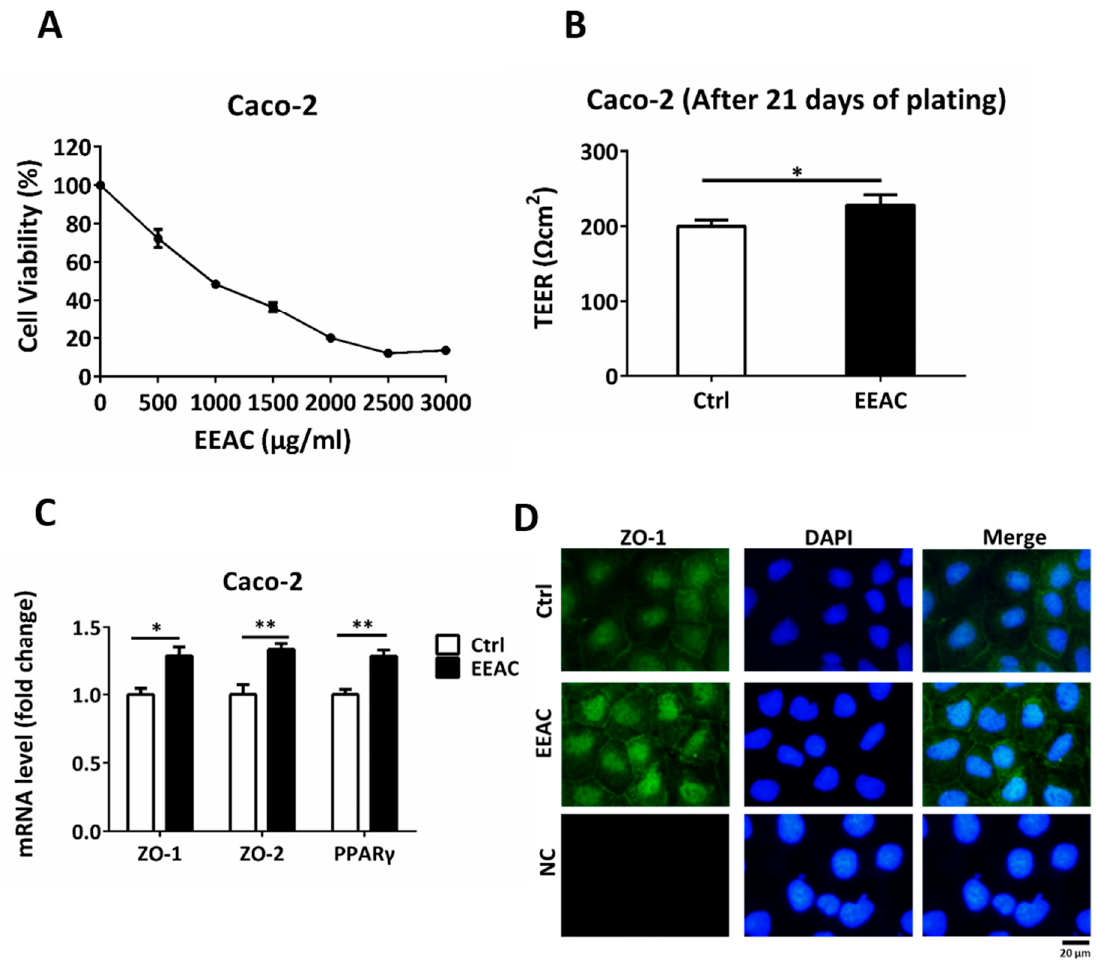
Figure 6. EEAC decreases intestinal permeability in the Caco-2 cell barrier model. ( A ) Cell viability assay of Caco-2 cells treated with 0-3000 µ L / mL EEAC. ( B ) E ff ect of EEAC on intestinal permeability was measured using the trans-epithelial electrical resistance (TEER) assay. ( C ) Relative mRNA expression of tight junction proteins and PPAR γ were compared using controls (Ctrl). ( D ) Immunofluorescence staining of ZO-1 (green) of Caco-2 cells treated with or without EEAC. Nuclei were stained with DAPI (blue). The negative control is marked as NC. Scale bars, 20 µ m. All data are expressed as mean ± SEM, * p < 0.05, ** p < 0.01, *** p < 0.001. Non-significant; ns. All experiments were repeated thrice ( n =